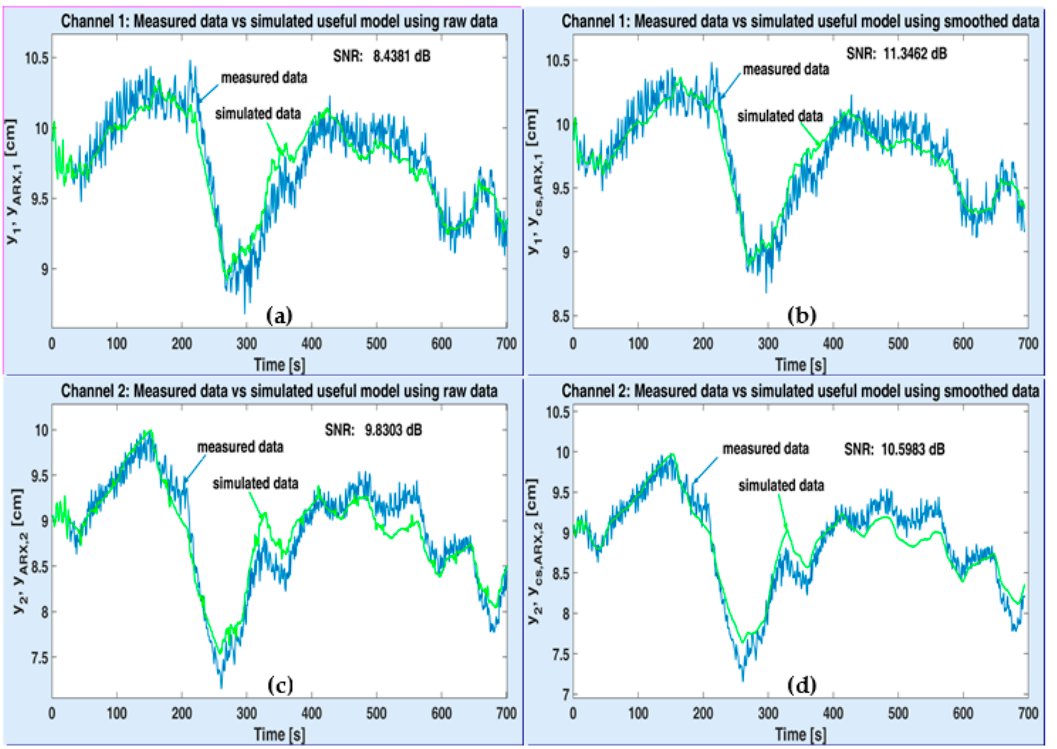
Figure 10. Performance of useful ARX models on channel 1 with raw data ( a ), smoothed data ( b ) and channel 2 with raw data ( c ), smoothed data ( d ).